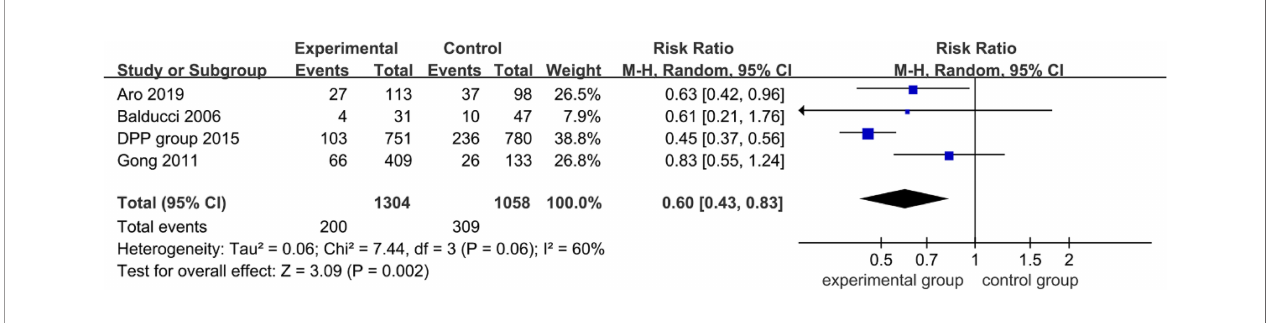
FIGURE 3 | Forest plot of